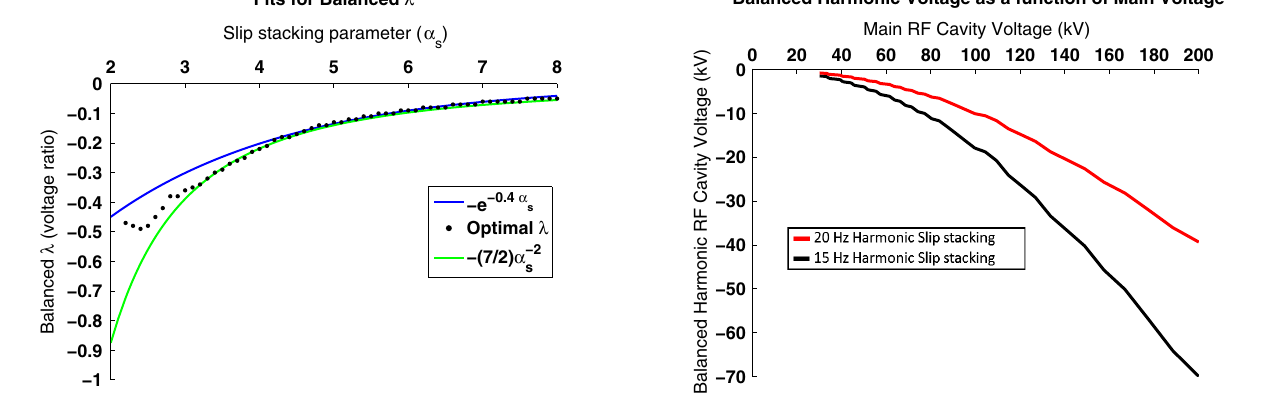
FIG. 5. Value of λ which maximizes phase-space area, as a function of α s .